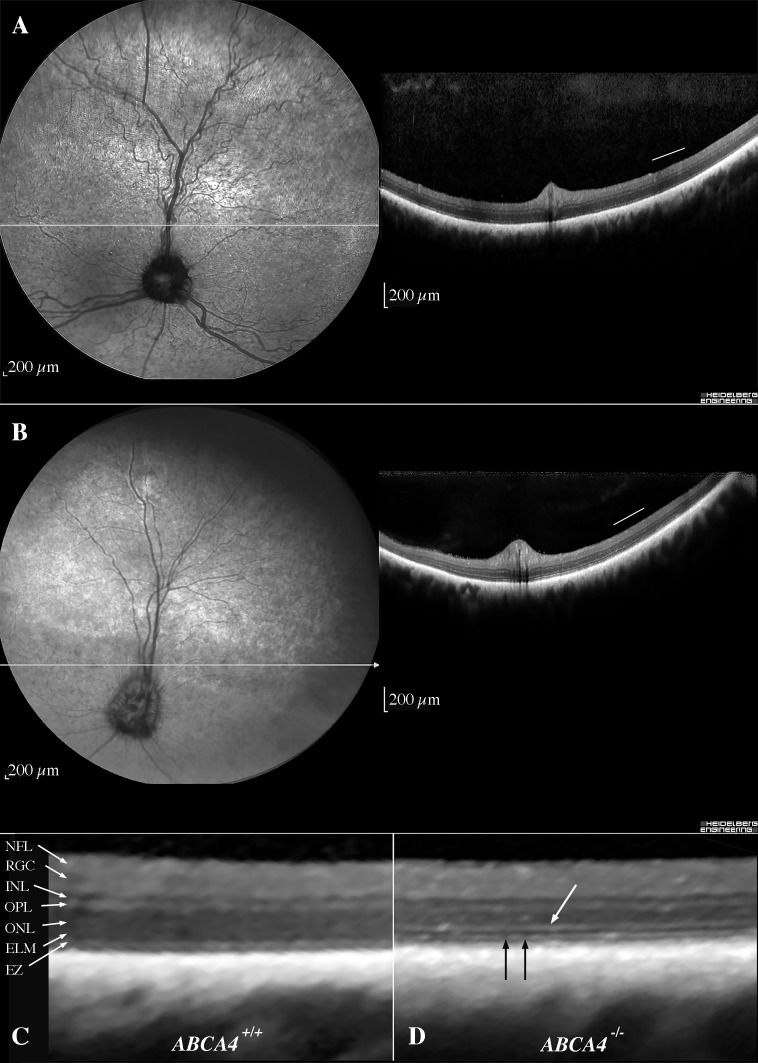
In vivo retinal morphology assessed with cSLO and OCT.cSLO-images (left) and OCTs (right) (A) from the left eye of a 12-year-old unaffected dog (LAB22) along the visual streak and (B) from the left eye of a 10-year-old affected dog (LAB10), where the horizontal extension of the visual streak is indicated by the black arrows. (C) A magnification of the temporal retina (corresponding to the area below the white bar in the OCTs) of the unaffected dog (LAB22) and accordingly (D) of the affected dog (LAB10), with thickened and hyperreflective ELM (white arrow) and fragmented EZ (black arrows). cSLO = confocal scanning laser ophthalmoscopy; OCT = optical coherence tomography; ELM = external limiting membrane; EZ = ellipsoid zone (inner-to-outer segment junction).